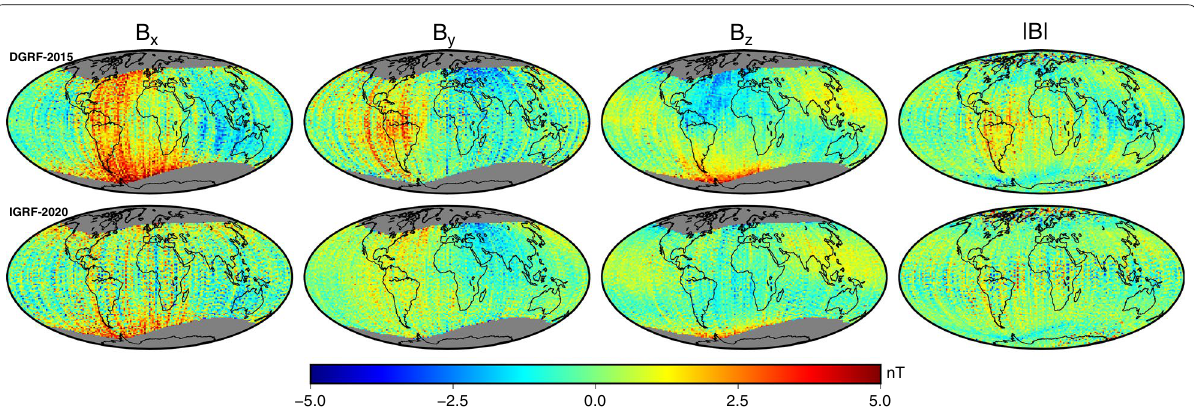
Fig. 1 Combined model residuals of Swarm A and B for DGRF-2015 parent model (top row) and IGRF-2020 parent model (bottom row)